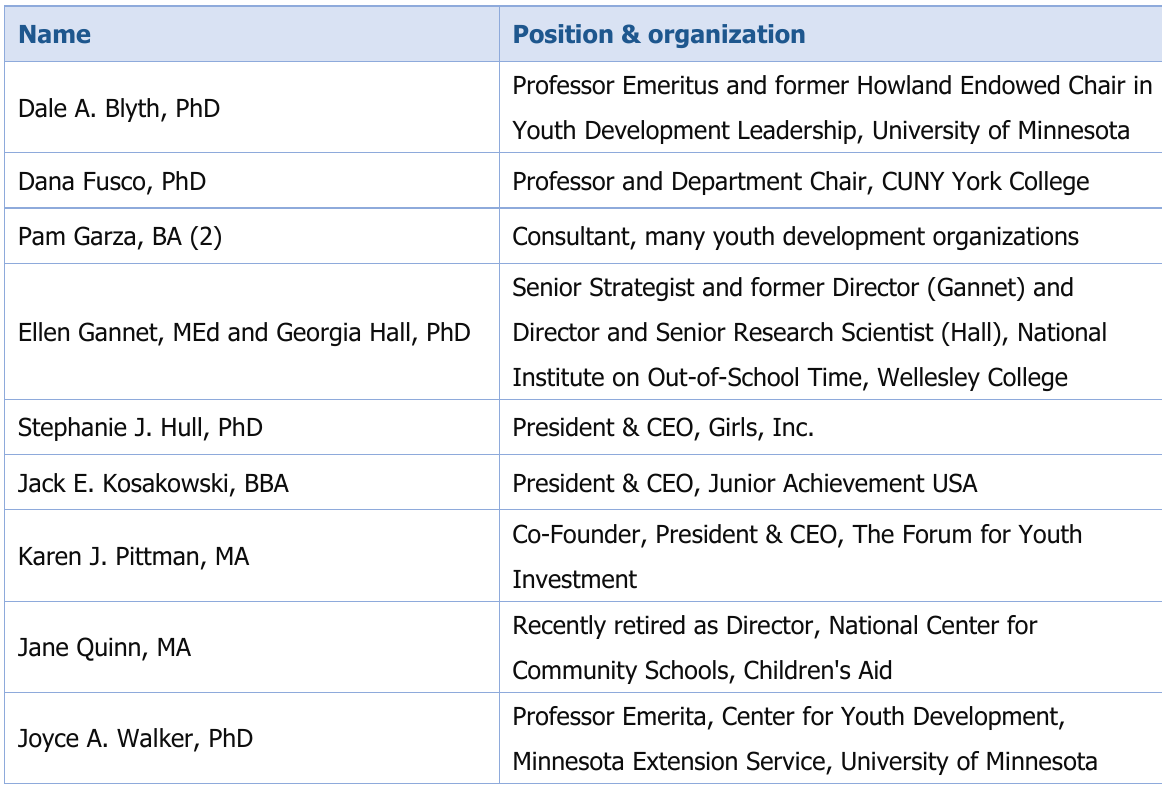
Table 1. Identification of Key Leaders in the Field of Youth Development